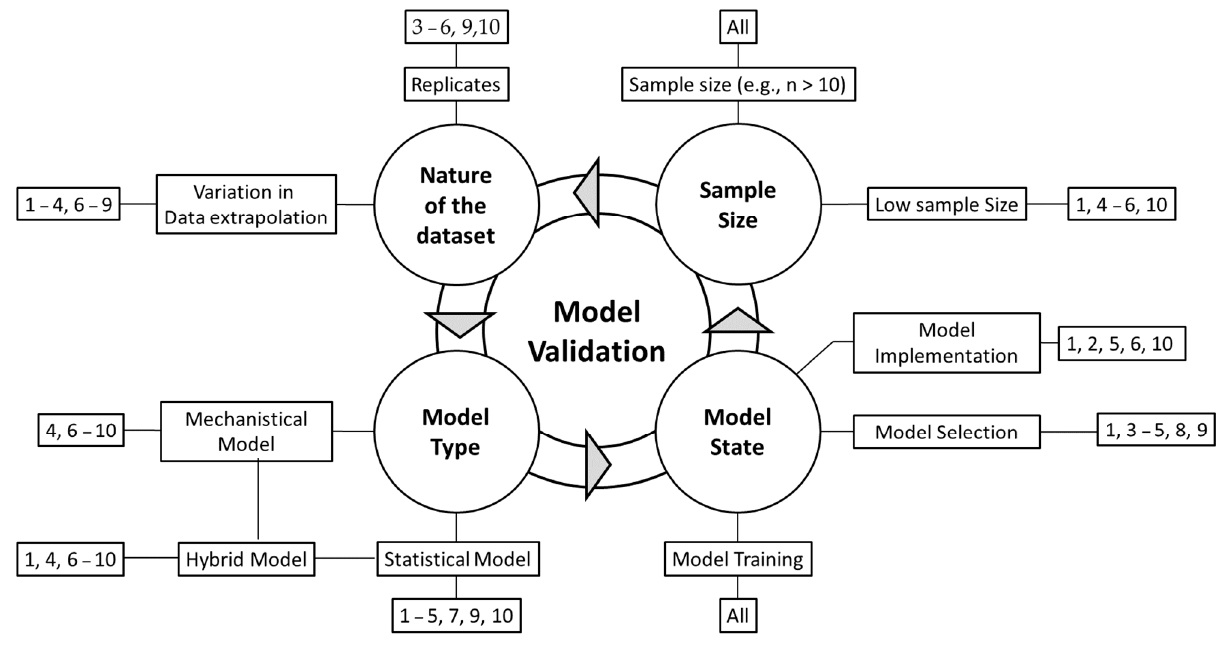
Figure 1. An overview of the different aspects to consider when choosing a validation statistic or method. Section 2 sub-headers, namely Sections 2.1–2.10 are denoted as 1–10.